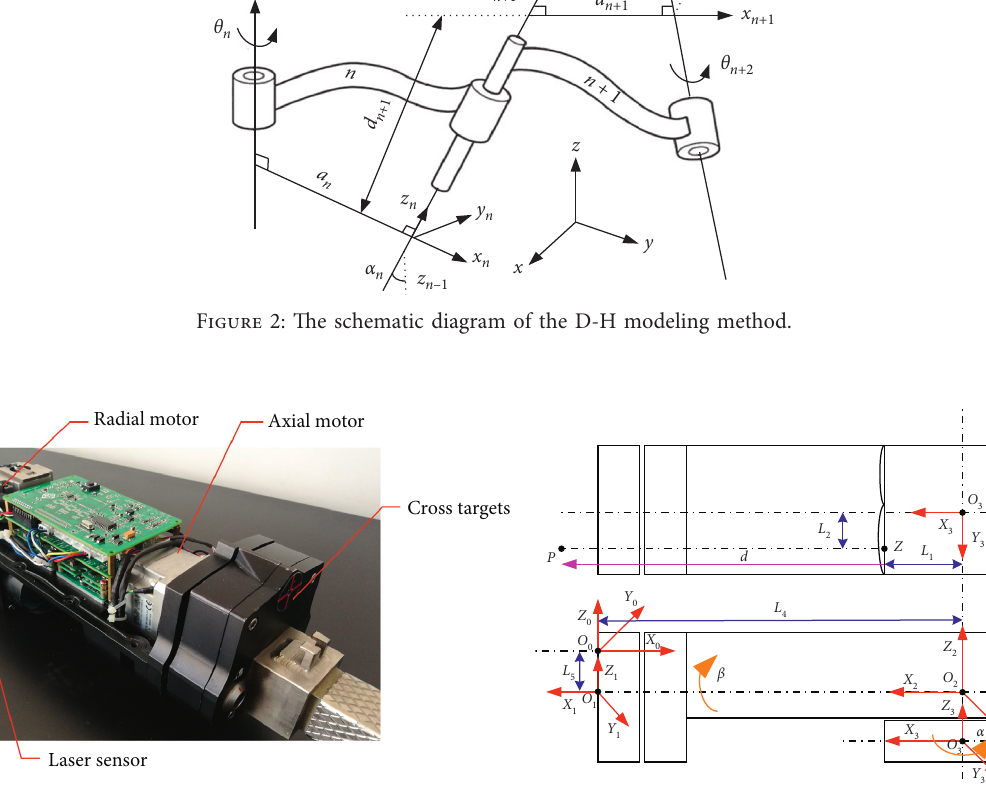
Figure 3: The inner structure of the 3D laser scanner and coordinate system for the D-H model.